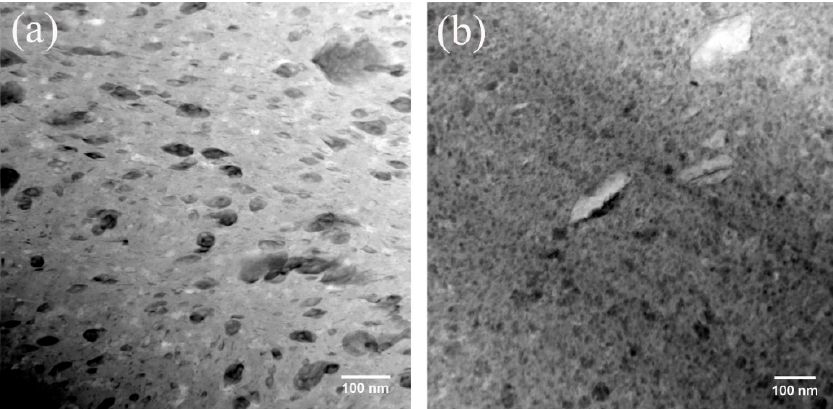
Figure 3. HAADF images of ( a ) Cu 65 Nb 5 Ag 10 (CuO) 10 alloy ball milled for (8 + 4) h; and ( b ) Cu6 5 Mo 5 Ag 10 (CuO) 10 alloy ball milled for (8 + 20) h.